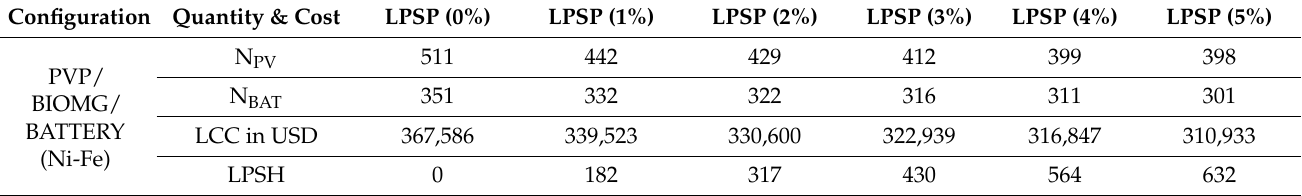
Table 6. Optimum configuration results for various LPSP